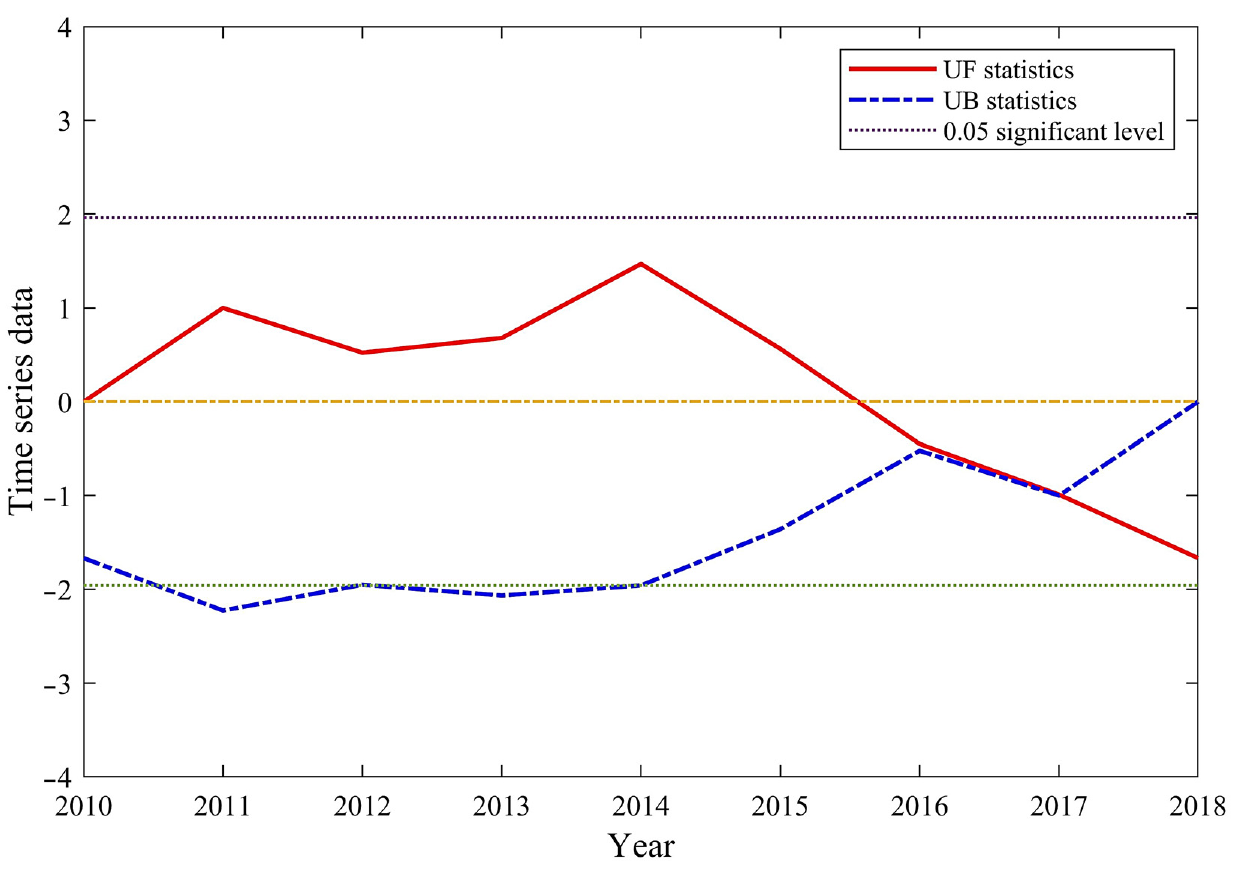
Figure 4. M-K mutation test curve.